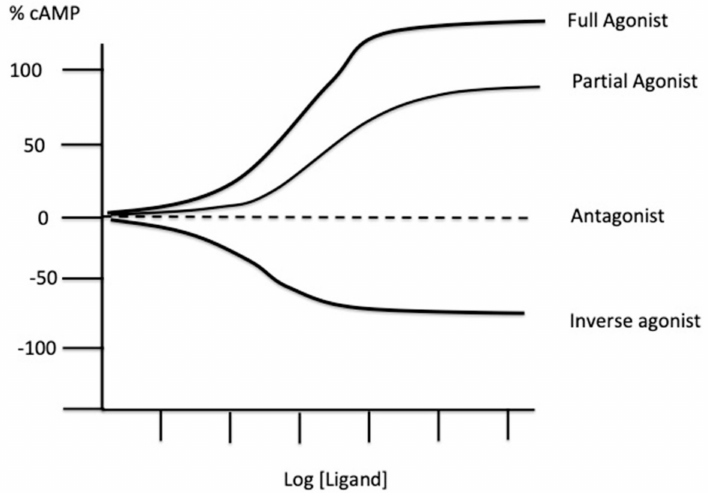
Figure 1. Functional consequences of the binding of a ligand (exogenous or endogenous) on its receptor. Agonists activate receptors, while classic antagonists occupy the agonist binding pocket and block agonist effects. Partial agonists have a lower efficiency than full agonists do. Inverse agonists stabilize the receptor in an inactivated state and decrease basal effects in a dose-dependent manner. Basal response can be expressed as % cAMP production. From [6],